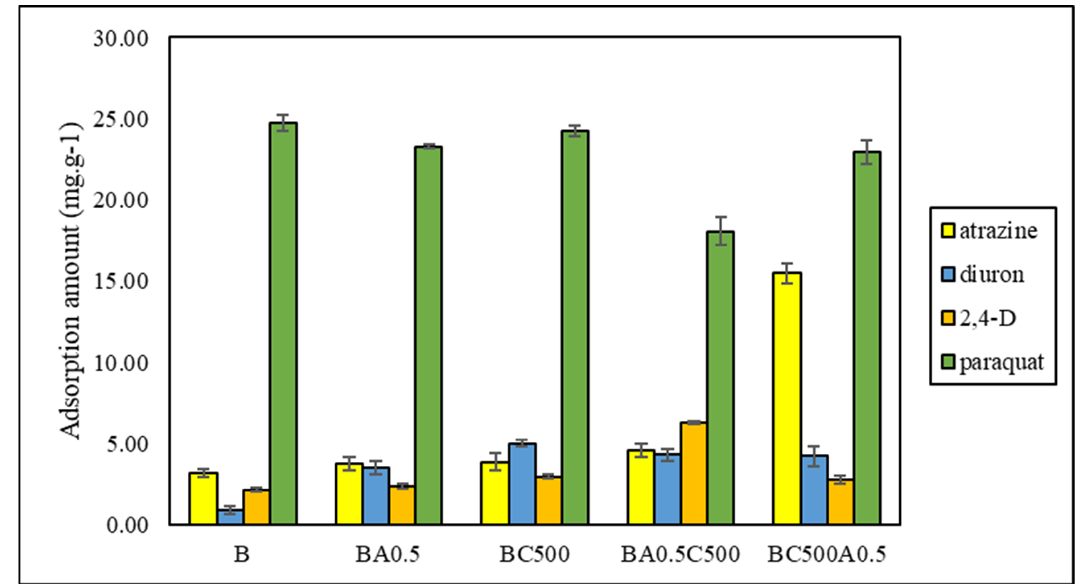
Figure 7. Adsorption of single-component pesticide with a concentration of 50 mg L − 1 at pH 6.5 ± 0.5 onto bentonite and modified bentonite.